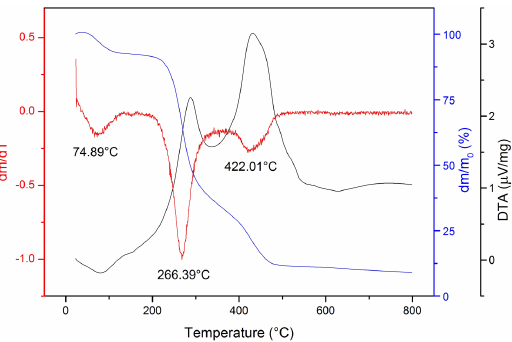
Figure 4. TG/DTG/DTA curves of In Natura BF. Bibliographic source: Author.